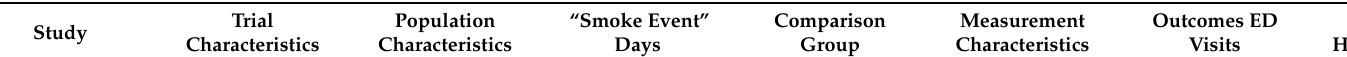
Table 1. Characteristics of included studies. Values that reach significance are in